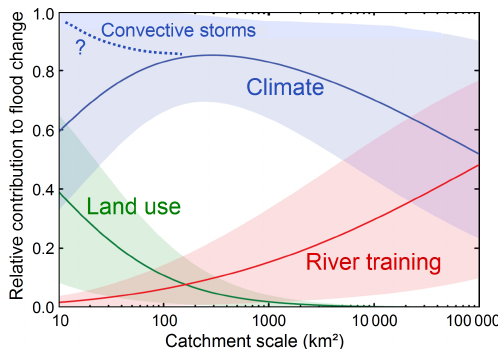
Figure 17. Synthesis of the relative contributions of land-use change, river training and climate change to flood-hazard changes as a function of catchment scale. Land-use change is most relevant for small catchments, river training for large catchments and climate change at all catchment scales. For small catchments, an increase in the frequency of convective storms may further exacerbate climate- change effects on floods (Viglione et al.,